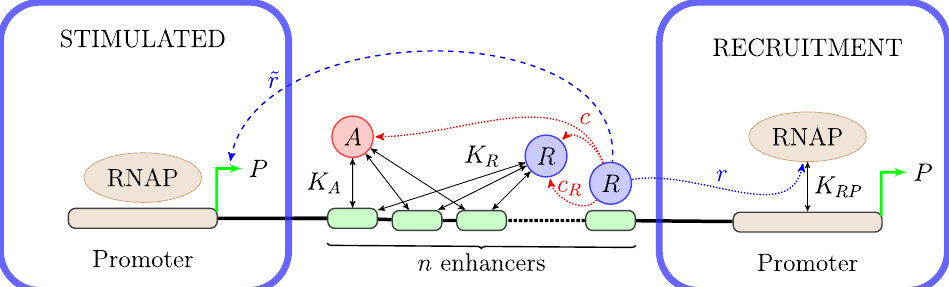
Figure 1. Representation of the biochemical mechanisms involved in transcriptional control. Com- petitive binding process of the TFs (red and purple circles) to n identical enhancers (green). RNA Polymerase (brown oval) binds to the promoter (brown rectangle). Affinities are indicated by black arrows. Alternative biochemical mechanisms are represented with discontinuous arrows: total vs. partial binding cooperativity between TFs (red) and recruitment vs. stimulated approaches for transcriptional control exerted by the TFs (blue). See assumption H2, HS4 and HR4 in Supplementary Materials Section S1 for